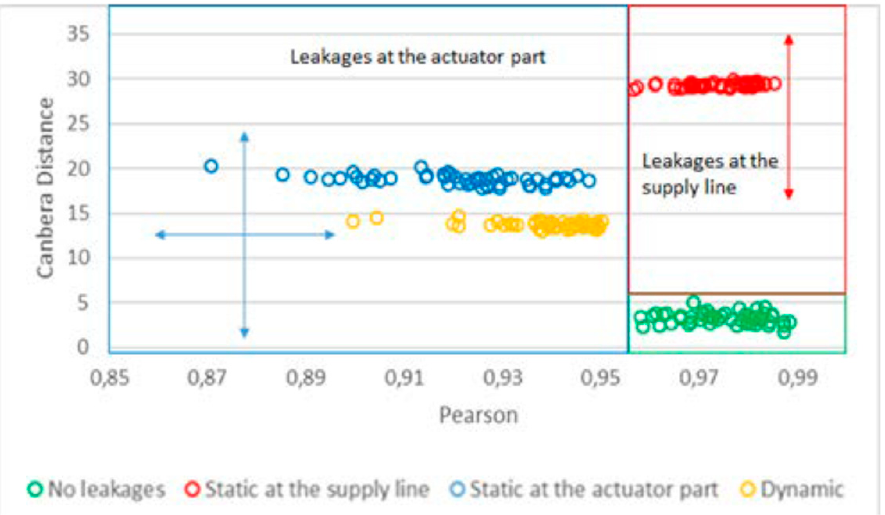
Figure 10. The classi fi cation obtained using the novel classi fi cation method whilst inducing di ff erent leak types